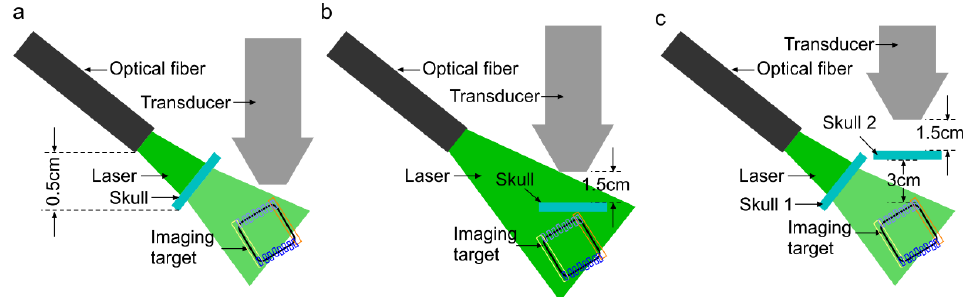
Figure 3. Schematic setups for imaging the square loop phantom with the skull as a barrier in: ( a ) the optical path, ( b ) the acoustic detection path, and ( c ) both the optical and acoustic detection paths. The optimized distances are calculated in Section 3.